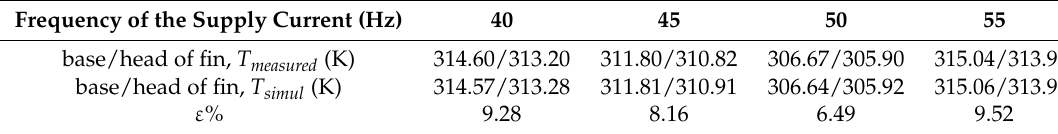
Table 3. Numerical results and their comparisons with experimental results.